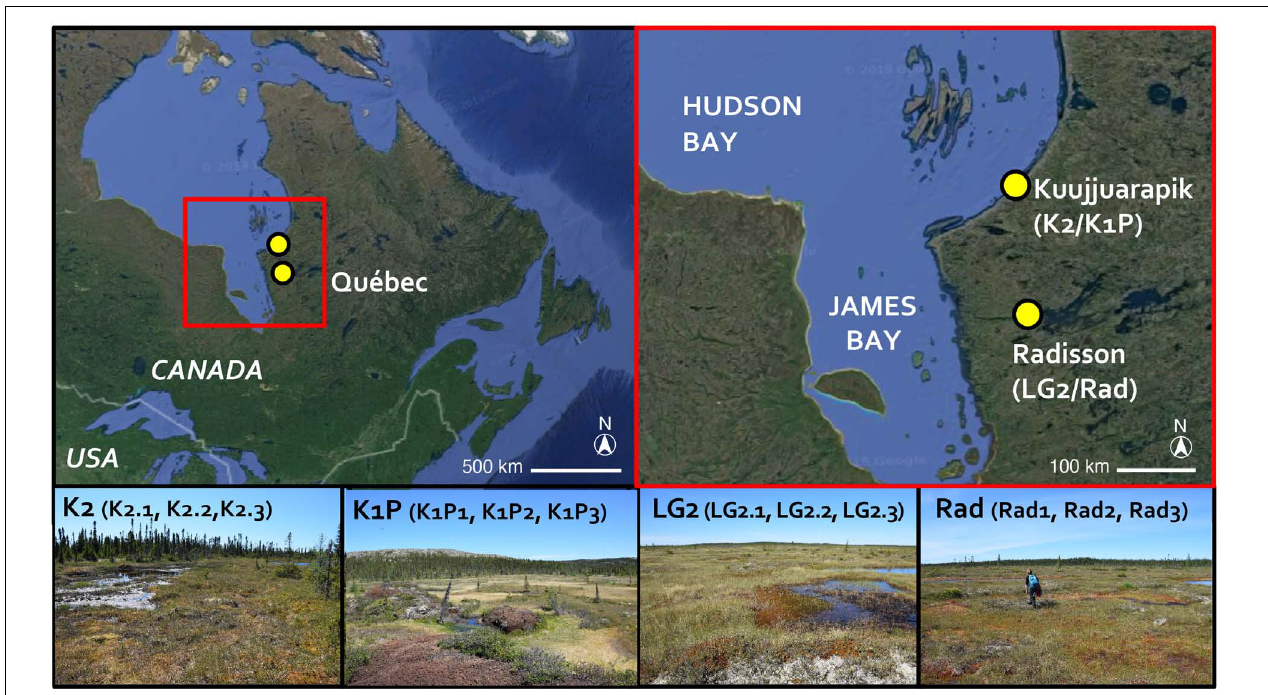
FIGURE 1 | Study site locations marked with yellow dots (base map © 2020 Google). Peatlands K2 and K1P are in Kuujjuarapik; LG2 and Rad are in Radisson. Pictures showing the coring sites (© SP) with the replicated three cores in each site